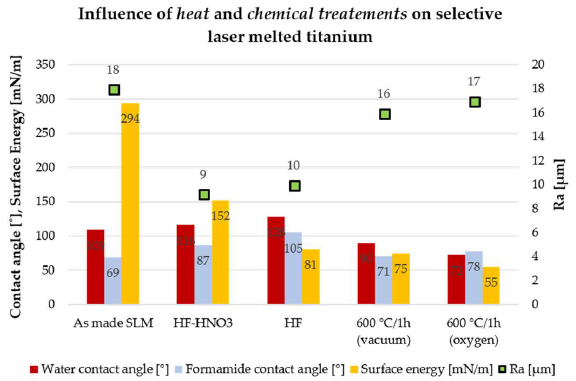
Figure 2. Influence of heat and chemical treatments on Ra parameter, water and formamide contact angle and surface